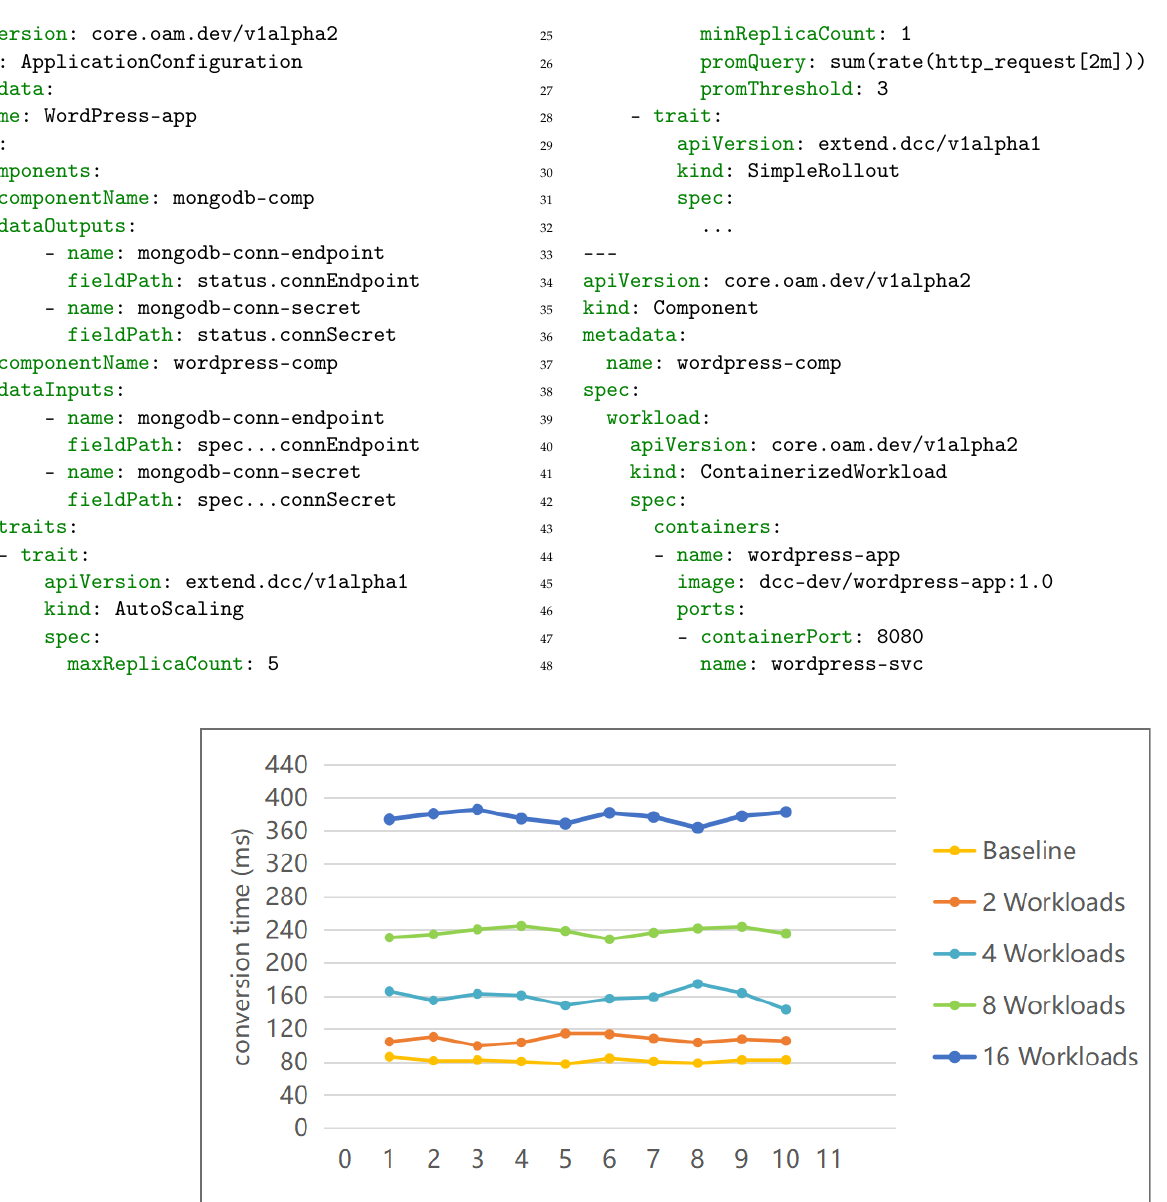
Listing 6. Resultant OAM Application Configuration.